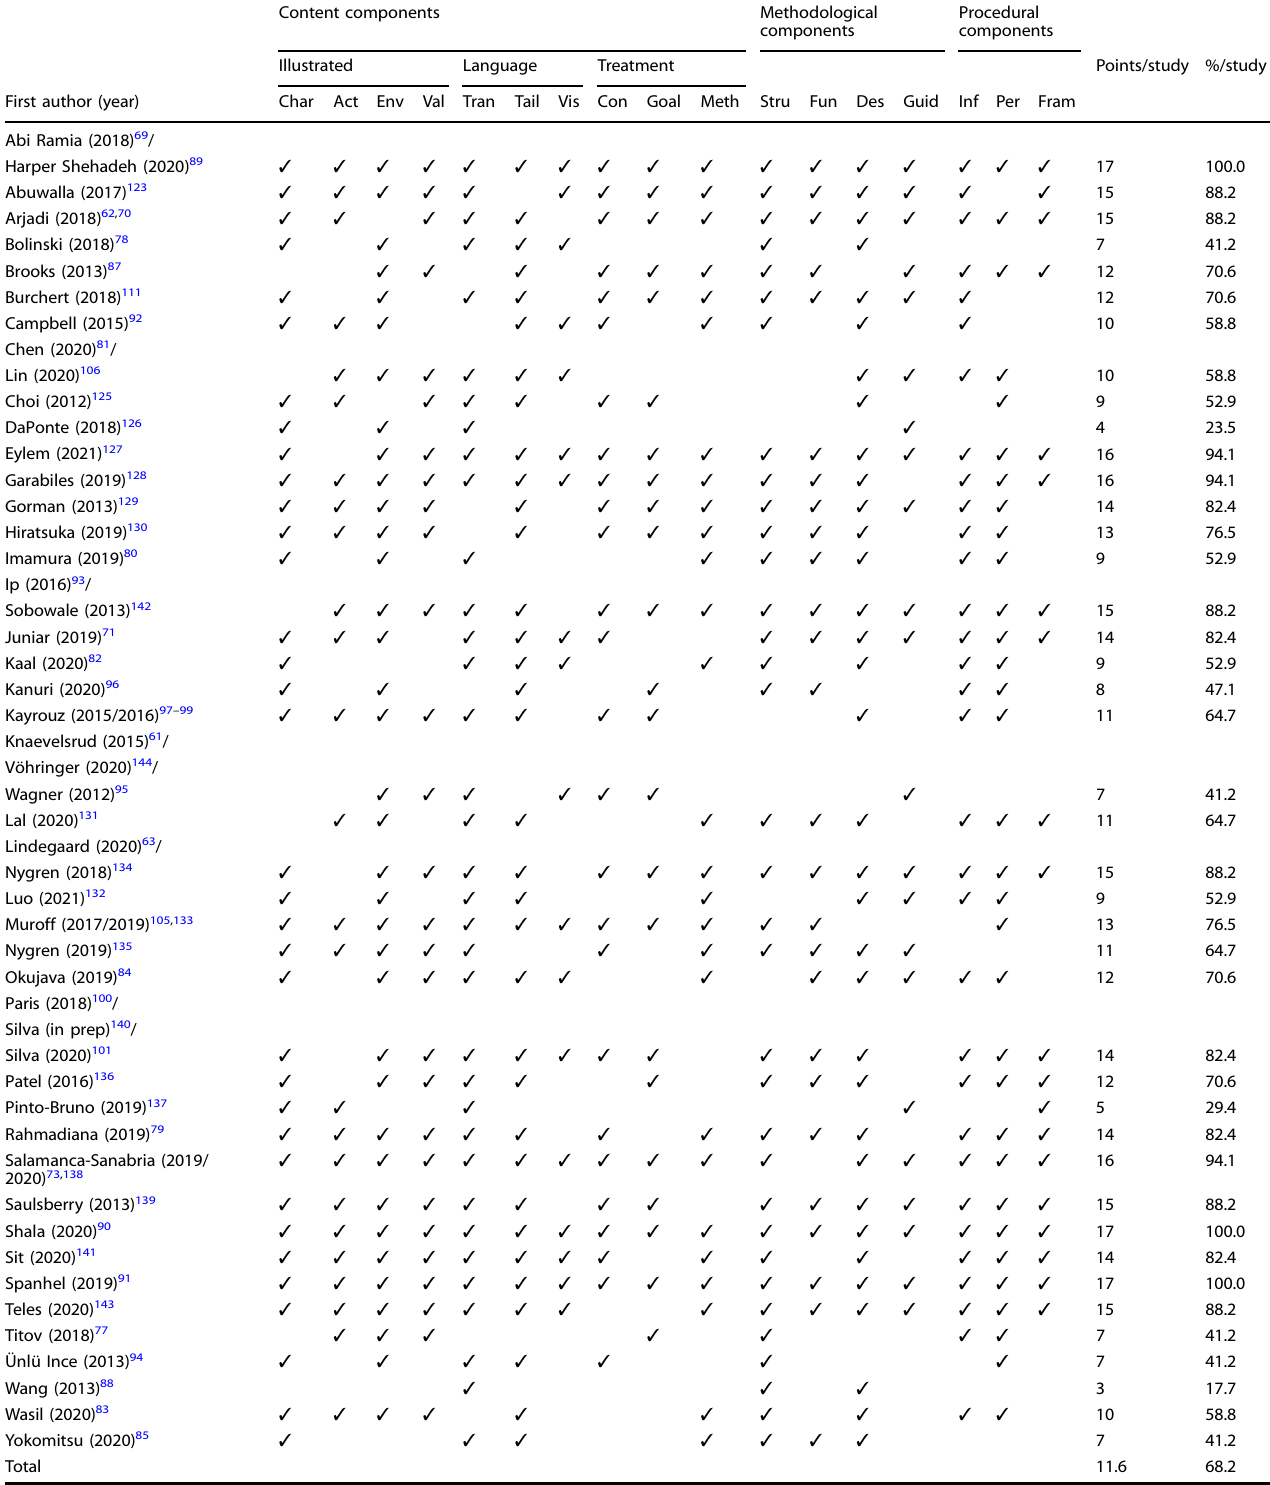
Table 3. Overview of the components used in the included articles during the cultural adaptation of their internet-and mobile-based based